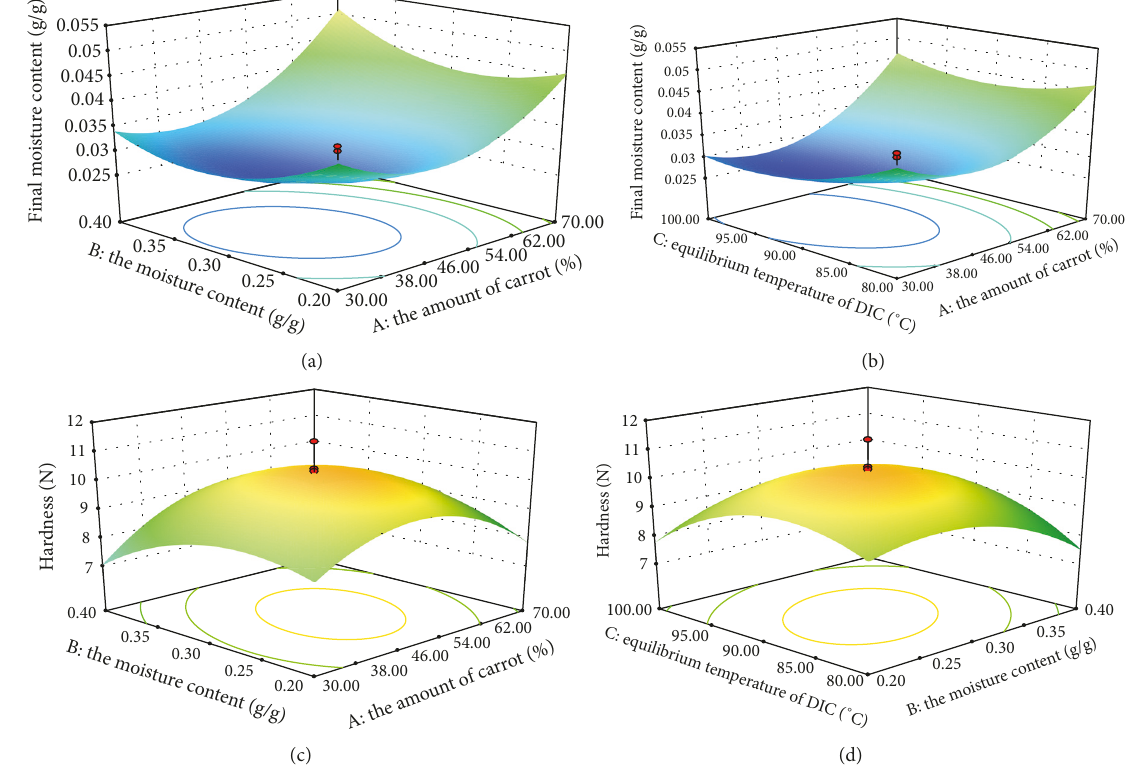
Figure 2: Response surfaces for the effects of the amount of carrot, the moisture content of the partially dried product before DIC treatment, and equilibrium temperature of DIC on the moisture content (a-b) and hardness (c-d) of the restructured carrot-potato chips dried by FD-